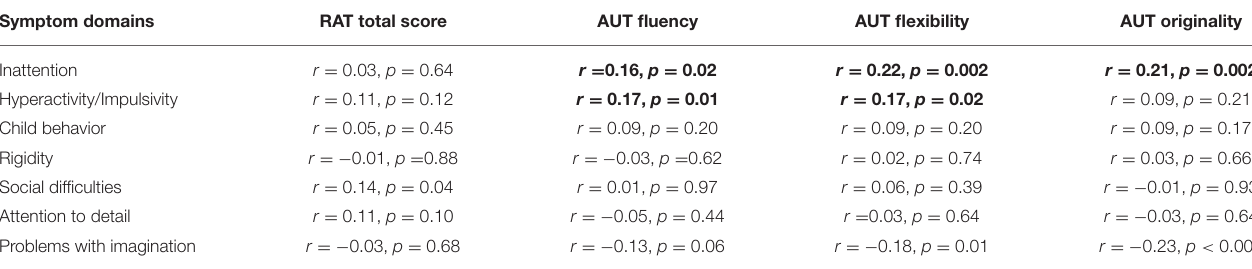
TABLE 4 | Exploration of the link between ADHD & ASD symptom domains and creative thinking in the BIG study (population–based sample). Symptom domains